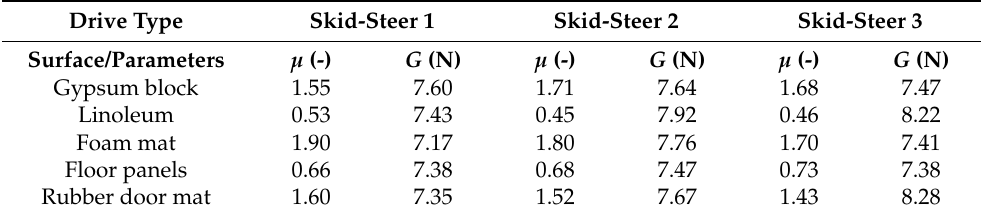
Table 8. The calculated µ and G for different robot and surface types. Drive